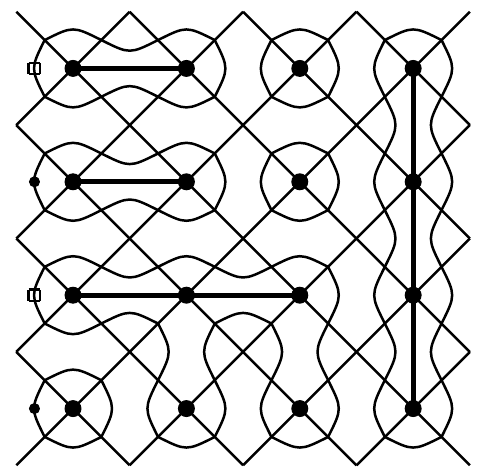
Figure 7 . The \alternating loop model": the \blobs" correspond to the operator b and the squares correspond to the operator u = 1 (cid:0) b .